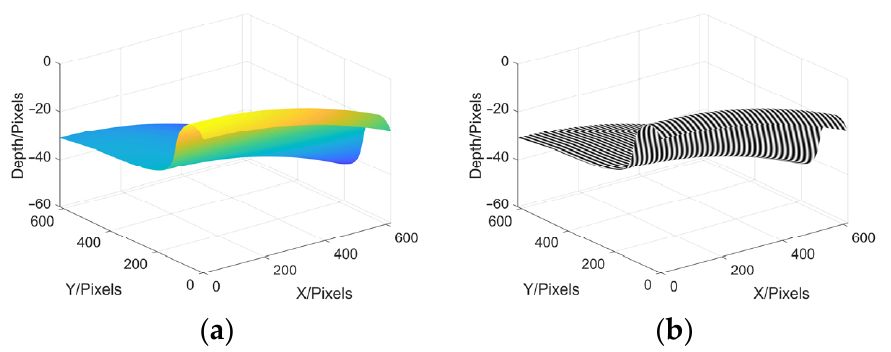
Figure 9. Create wheel tread and project sinusoidal grating fringe pattern. ( a ) wheel tread to be tested; ( b ) projection.